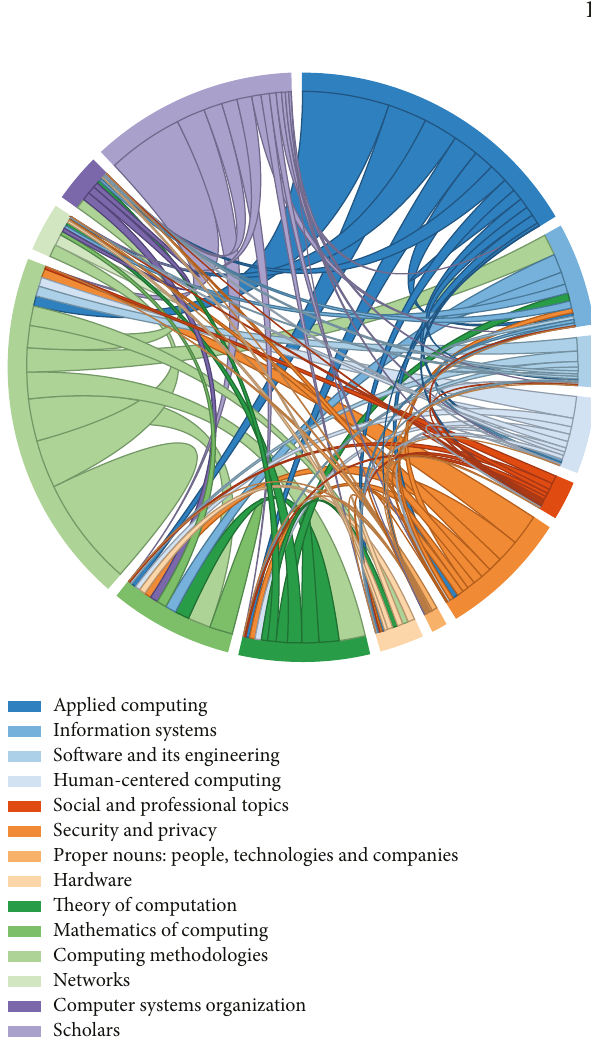
Figure 5: The interdisciplinary citations among articles in computer science